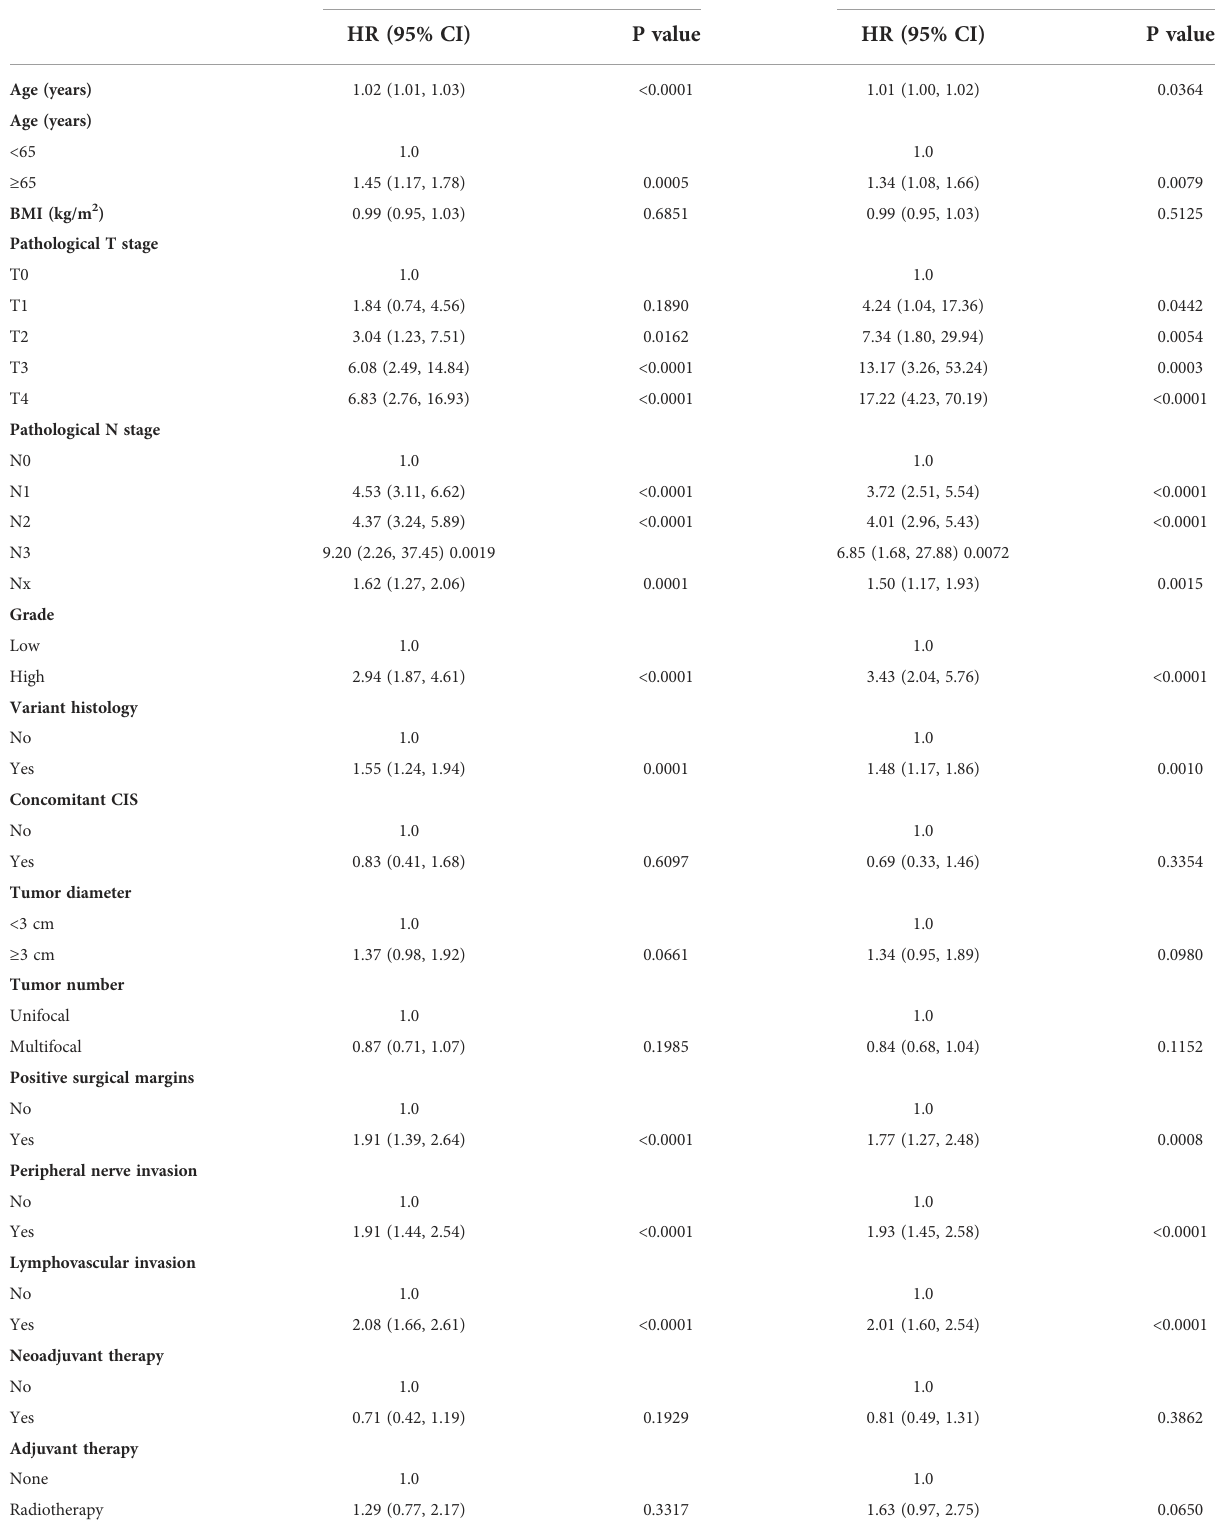
TABLE 2 Univariate analyses of the association between baseline characteristics and overall survival (OS) and recurrence-free survival